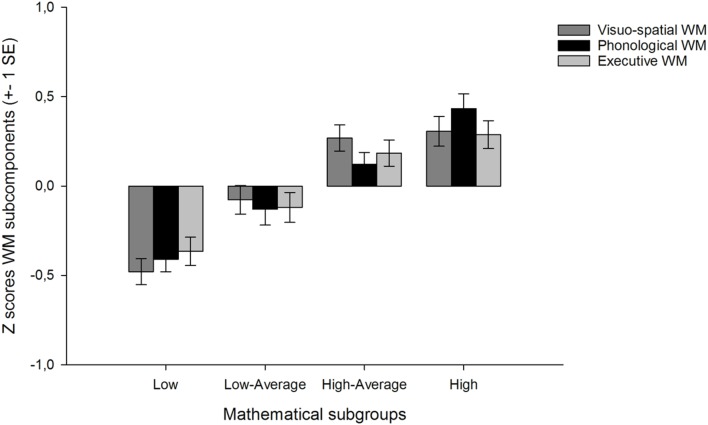
The working memory subcomponents and mathematical subgroups. For illustrative purpose, the figure contains the z-transformed working memory scores.